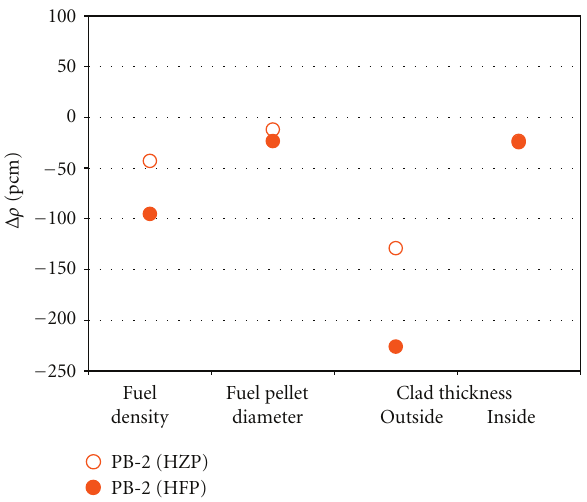
Figure 8: Manufacturing sensitivities for PB-2 test